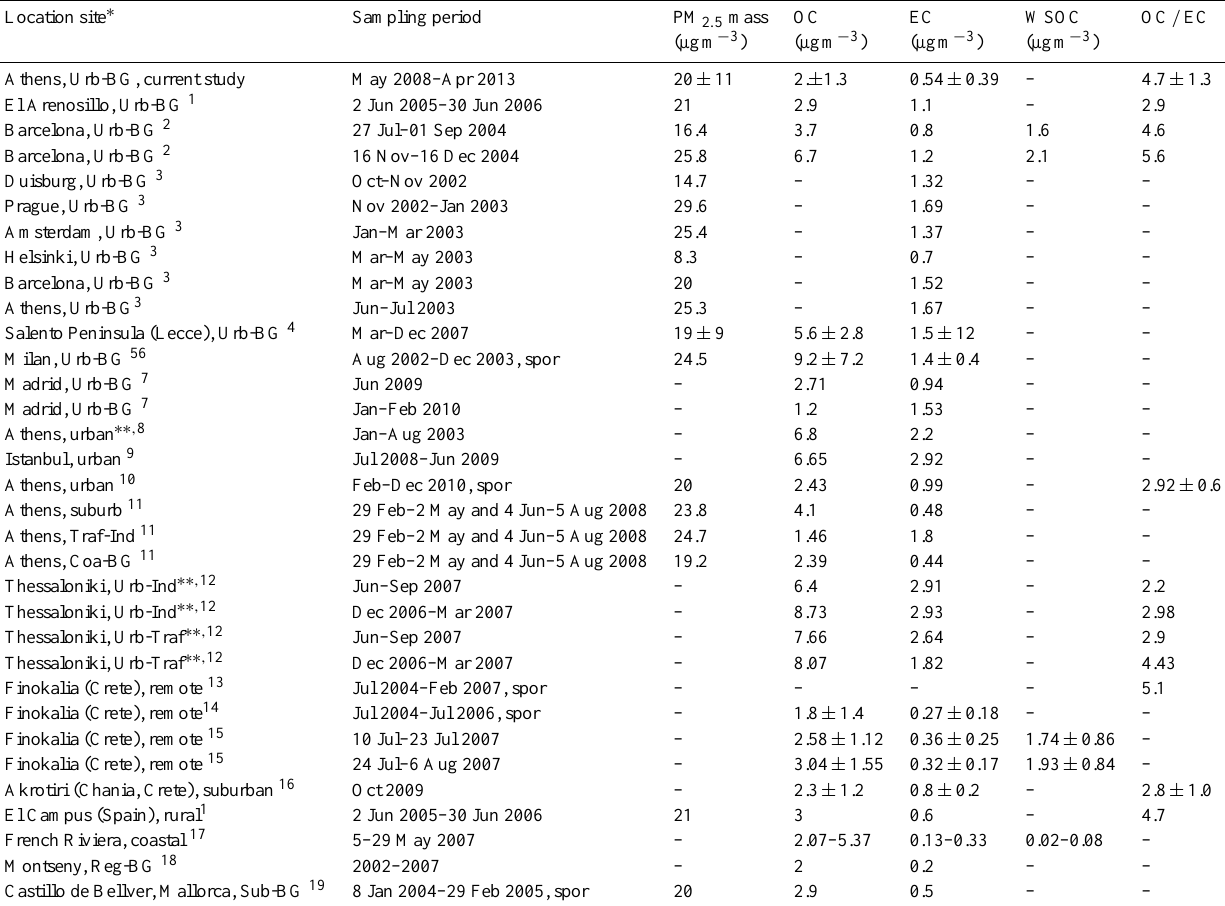
Table 1. PM 2 . 5 mass, OC, EC, WSOC concentrations and OC / EC ratios reported in the literature and compared to this